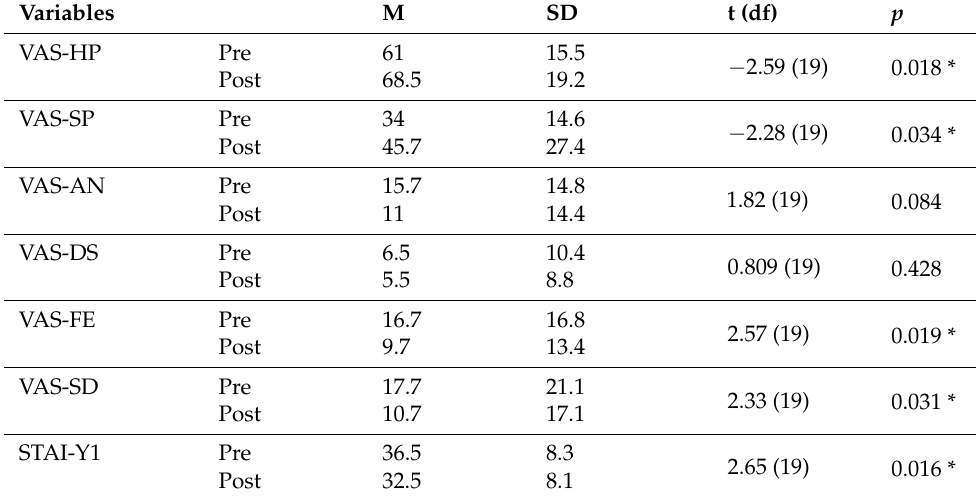
Table 3. Paired t -tests on VAS-E and STAI-Y1 in the sample (N = 20). * p < 0.05.